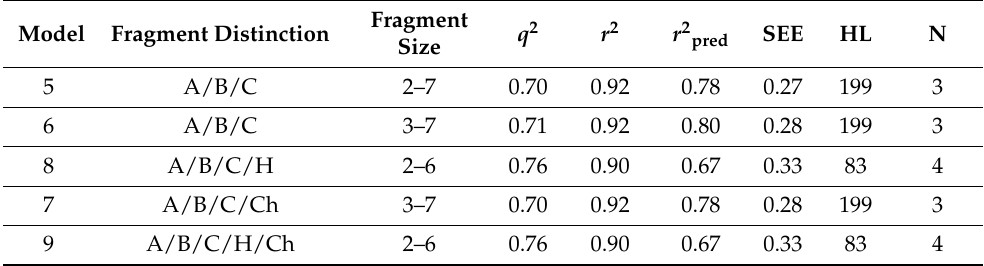
Table 3. Best HQSAR models obtained by varying fragment size. Model Fragment Distinction